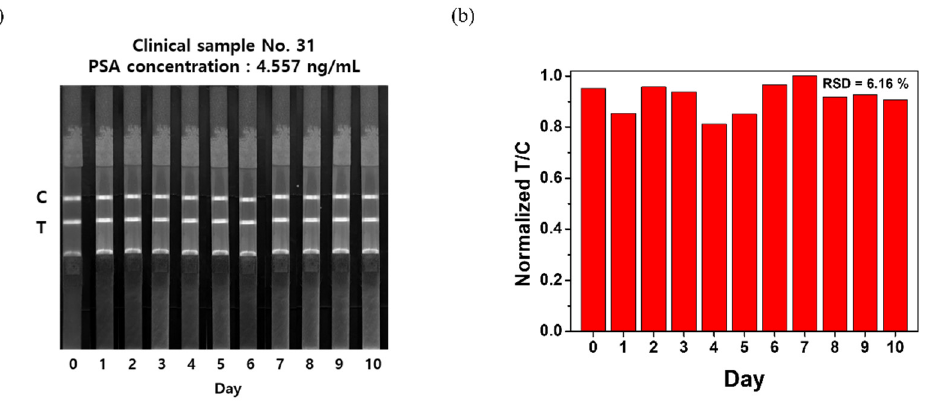
Figure 5. ( a ) Fluorescence image showing only the red channel of the test strip (stored for 10 d) after the development of 4.557 ng/mL of human serum sample under a 365 nm UV lamp for the stability test; ( b ) normalized T/C value of the developed human serum sample.